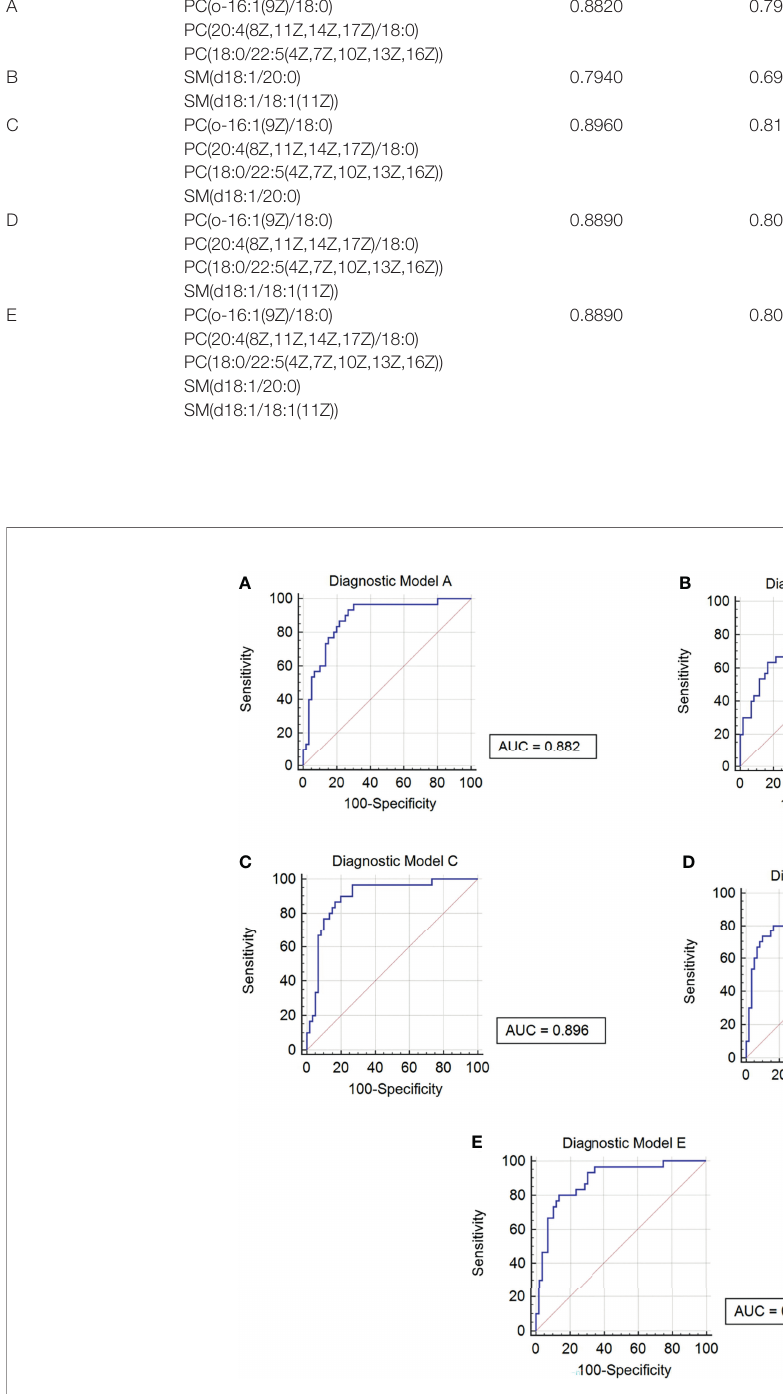
FIGURE 7 | ROC curves of 5 diagnostic models. (A) Diagnostic Model A contained PC(o-16:1(9Z)/18:0), PC(20:4(8Z,11Z,14Z,17Z)/18:0) and PC(18:0/22:5 (4Z,7Z,10Z,13Z,16Z)). (B) Diagnostic Model B contained SM(d18:1/20:0) and SM(d18:1/18:1(11Z)). (C) Diagnostic Model C contained PC(o-16:1(9Z)/18:0), PC(20:4